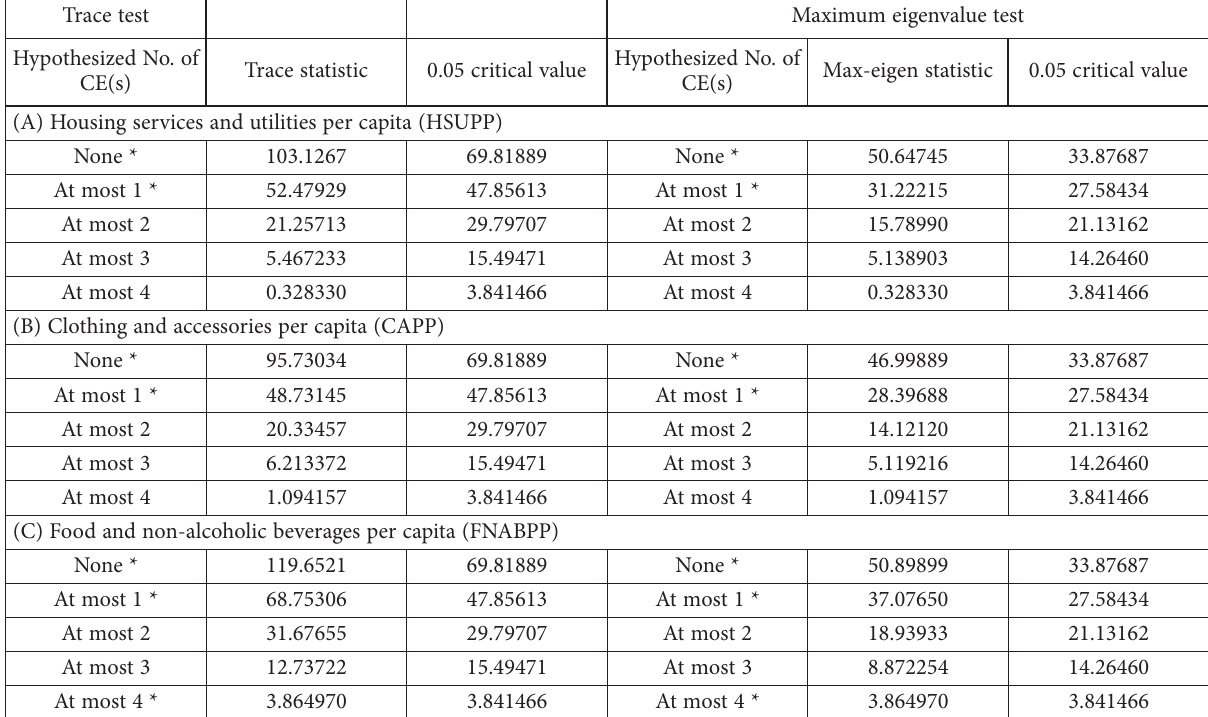
Table 7. Johansen test for cointegration on sub-categories of non-durable goods